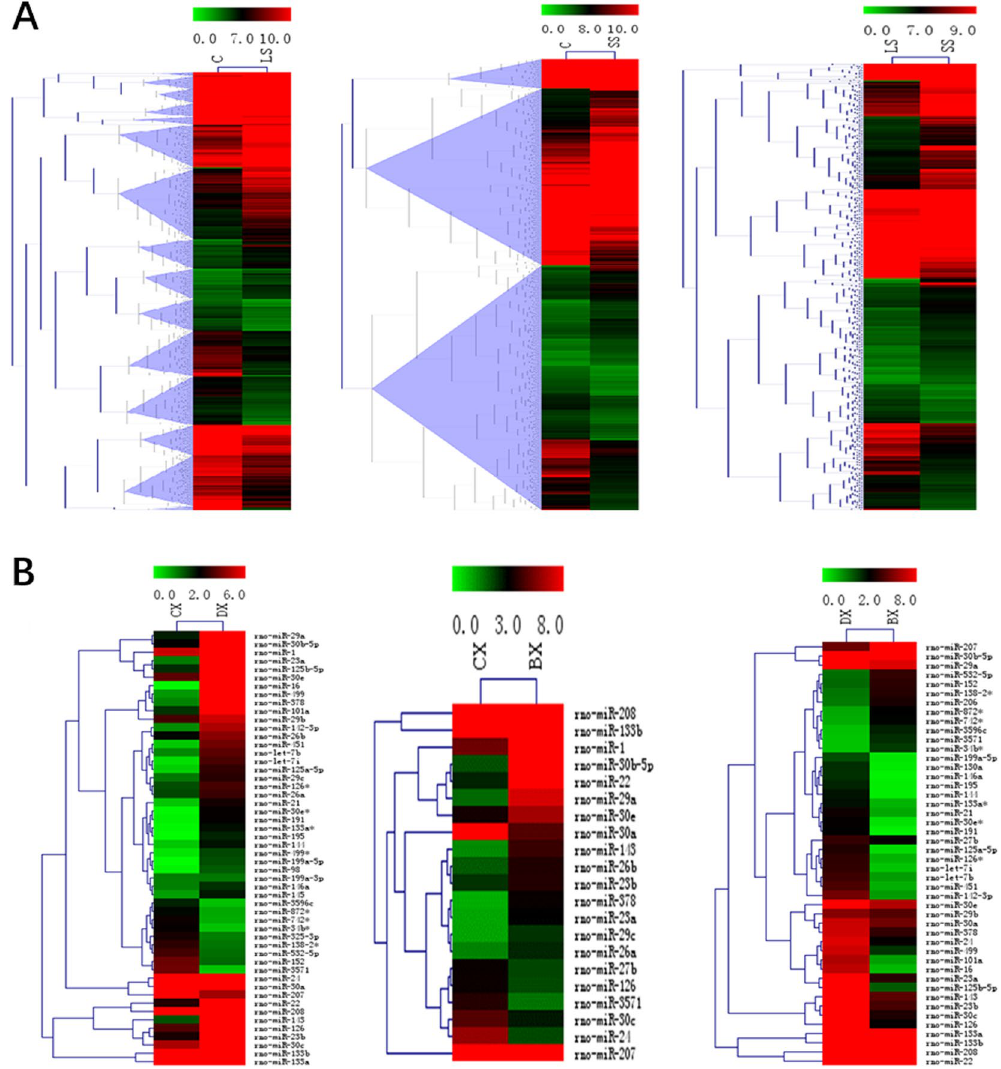
Figure 4. Differential mRNA ( A ) and miRNA ( B ) expression between any two groups of control group, low selenium group and selenium supplementation